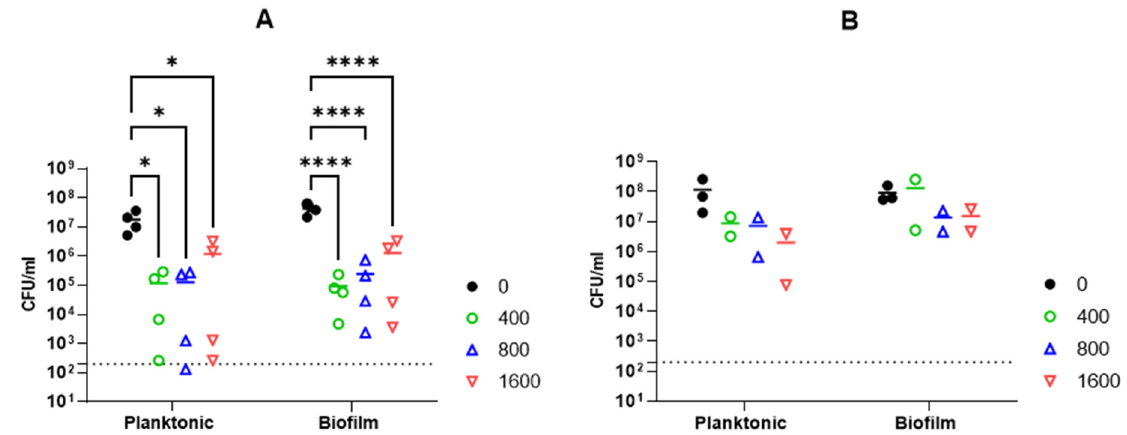
Figure 4. The effect of 3 h treatment of Abp013 on A. baumannii ATCC 17961 biofilm that has been pre-grown for 3 h ( A ) or 24 h ( B ). Both planktonic and biofilm cells were collected from the same sample well, with planktonic cells referring to the suspended cells present in the treatment buffer prior to the washing and collection of biofilm cells. Statistical significance was determined using a two-way ANOVA with multiple comparison across treatment groups. * p < 0.05; **** p < 0.0001. The dashed line indicates the limit of detection. A total of 4 and 2 independent experiments were carried out for 3 h ( A ) and 24 h ( B ) biofilms, respectively, each with 2 technical replicates. Each data point represents the averaged data of an independent experiment.